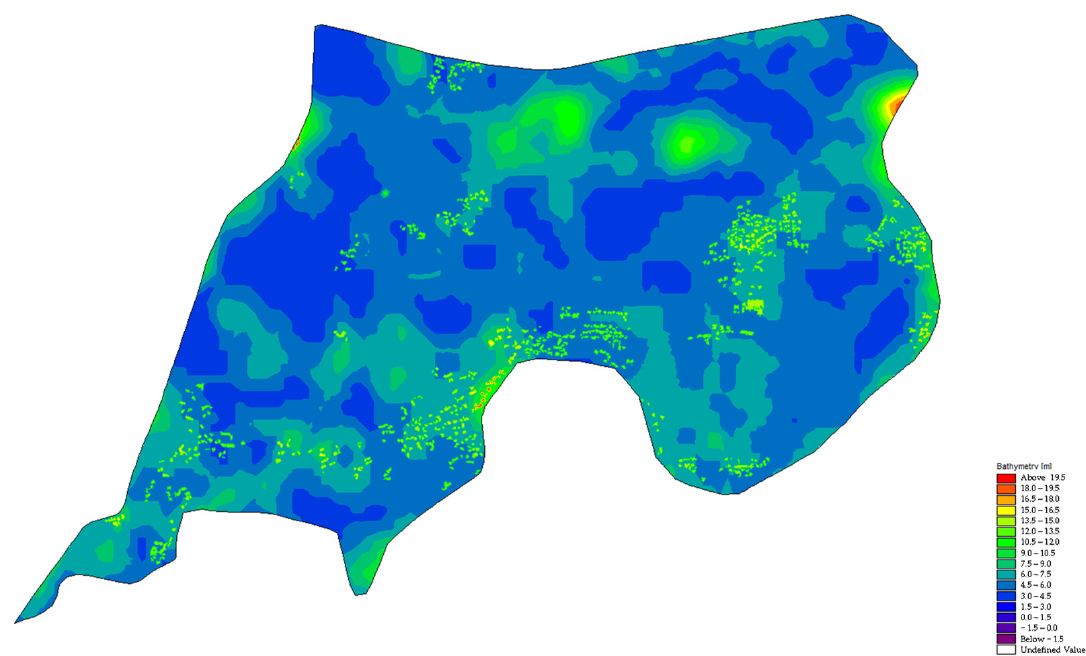
Figure 5. Elevation model of study area.